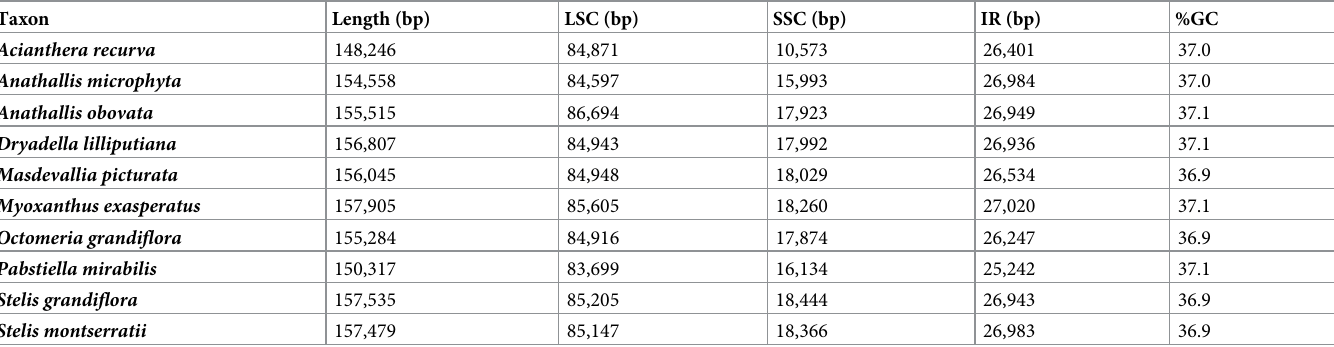
Table 1. General characteristics of Pleurothallidinae plastomes analyzed.